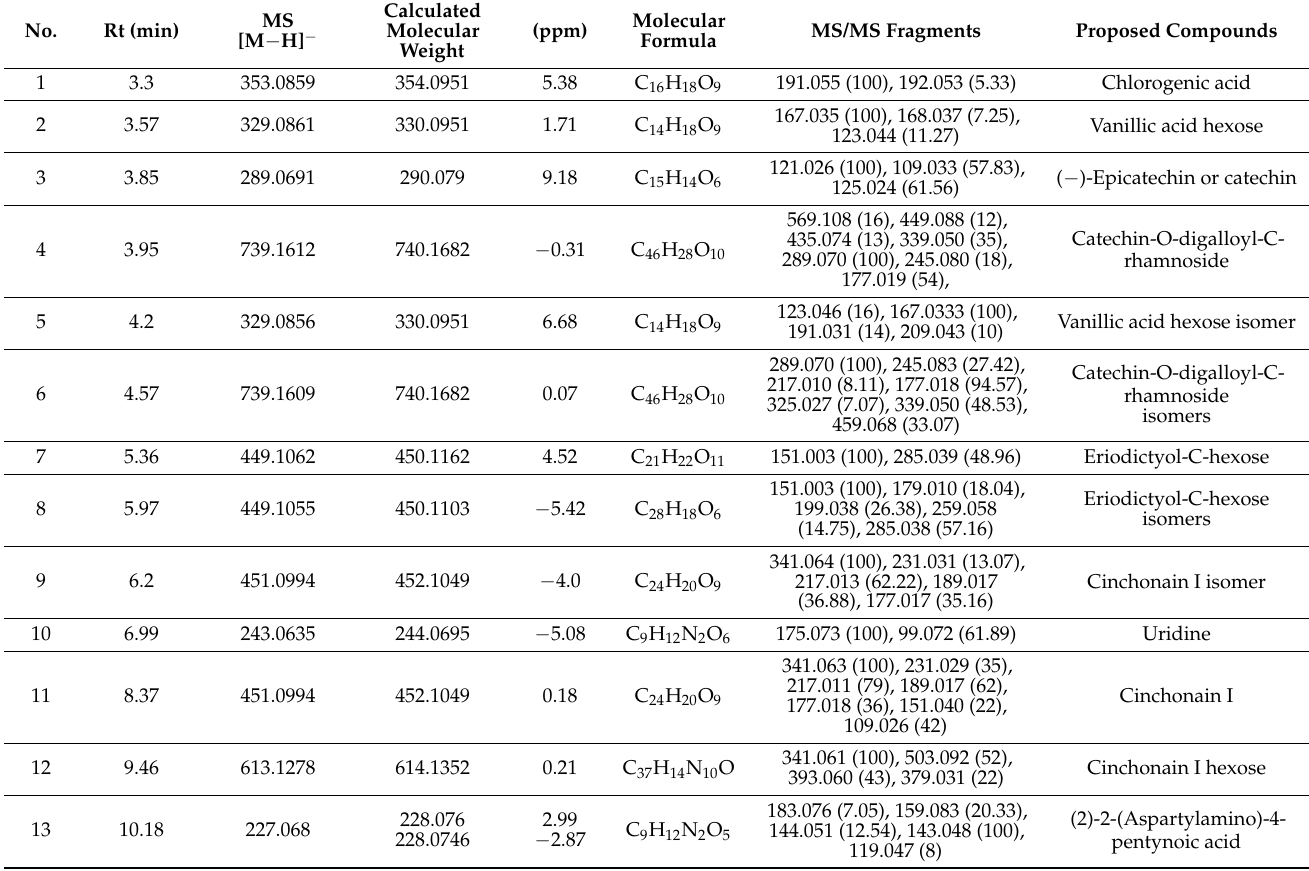
Table 3. The main constituents of the EtOAc fraction detected using HPLC-MS.